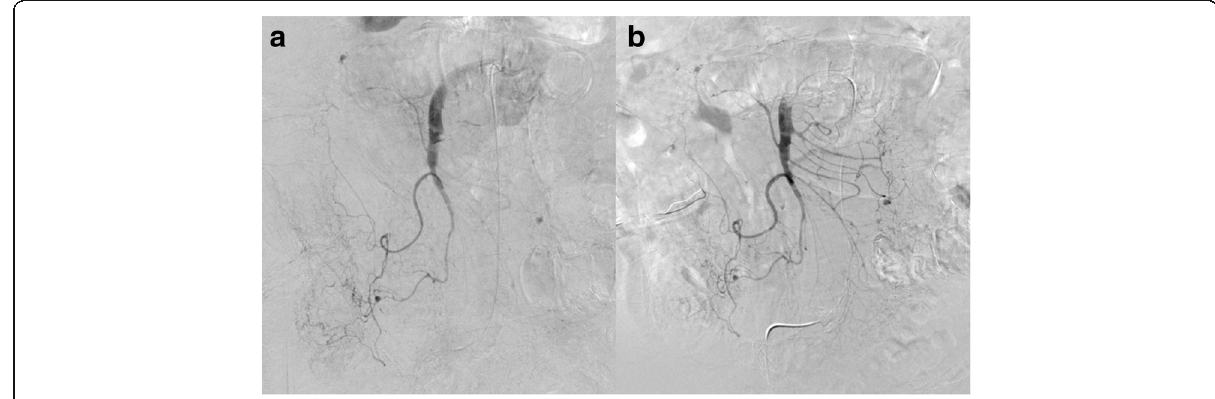
Fig. 4 a , b : Selective mesenteric arteriography ( a ). Infusion of papaverine restored the blood flow ( b